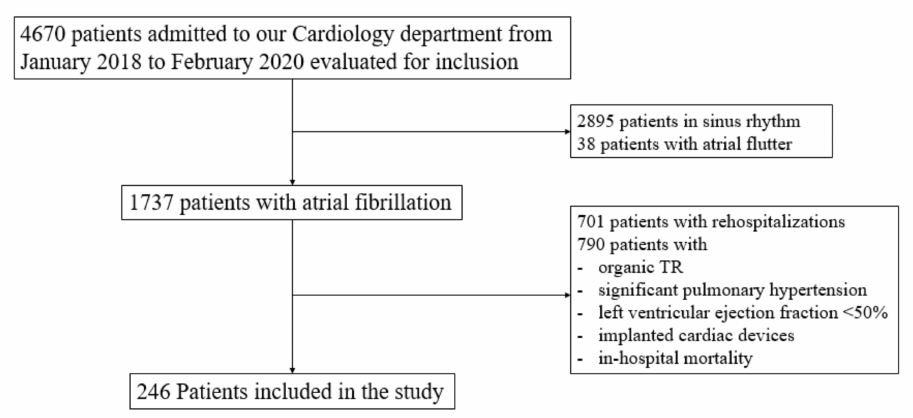
Figure 1. PRISMA consort flow diagram of the